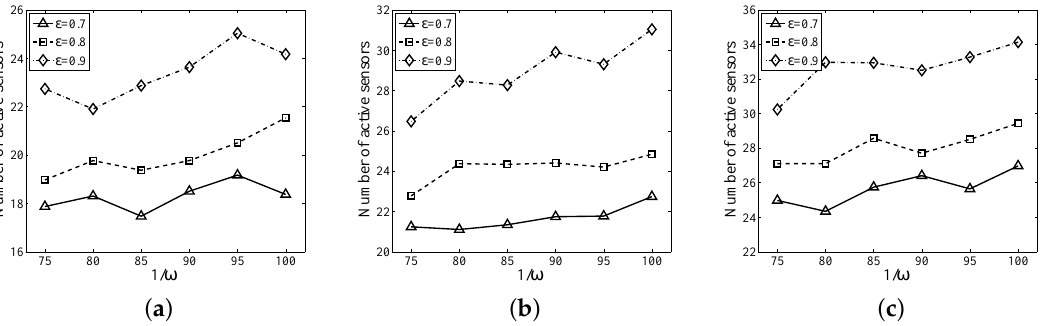
Figure 8. Performance of MVMFA with different sensor densities ω and (cid:101) . ( a ) | D | = 15; ( b ) | D | = 20; ( c ) | D | =